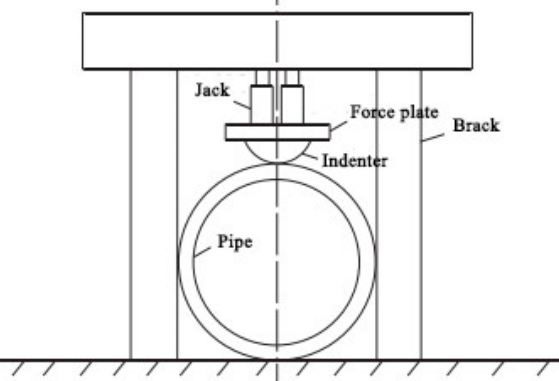
Figure 4. Dent springback test device.